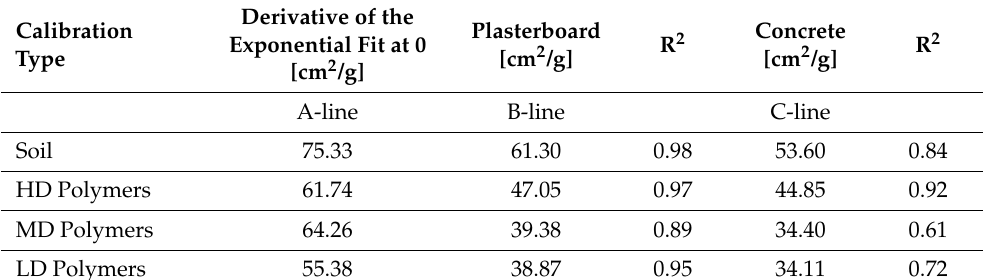
Table 1. Coefficients of the linear regression and R-square values for four types of calibrations and two types of